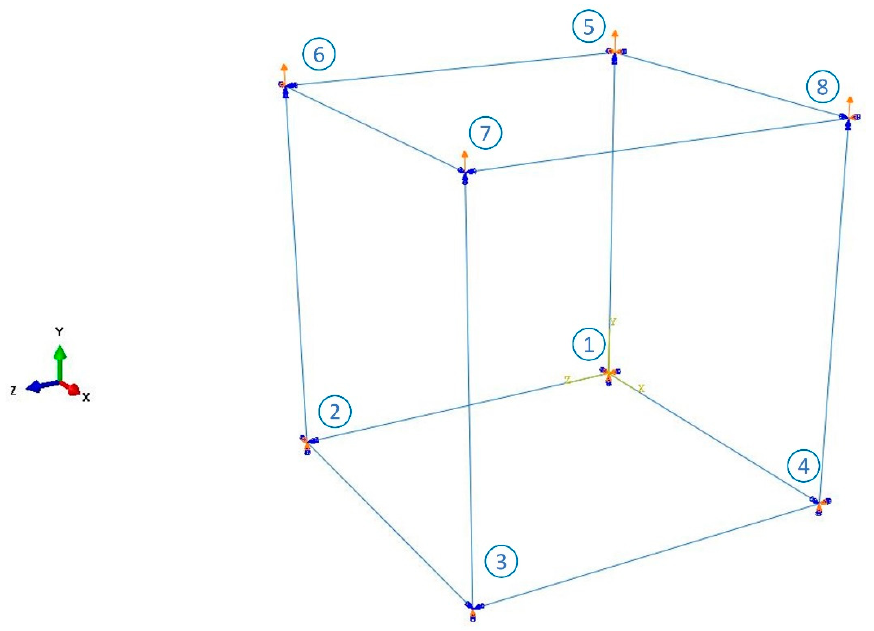
Figure 8. The boundary conditions for the unit cell model in the optimization process.